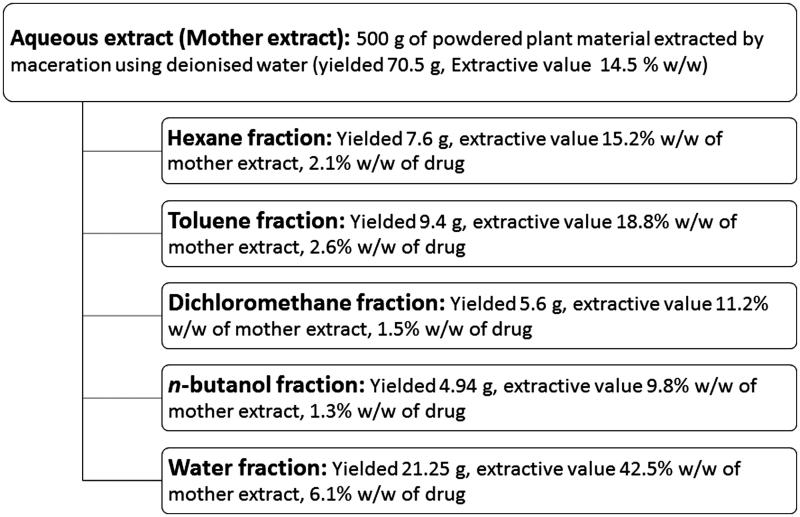
Schematic representation of extraction and fractionation of aqueous extract (mother extract) of gokhru showing extractive values.